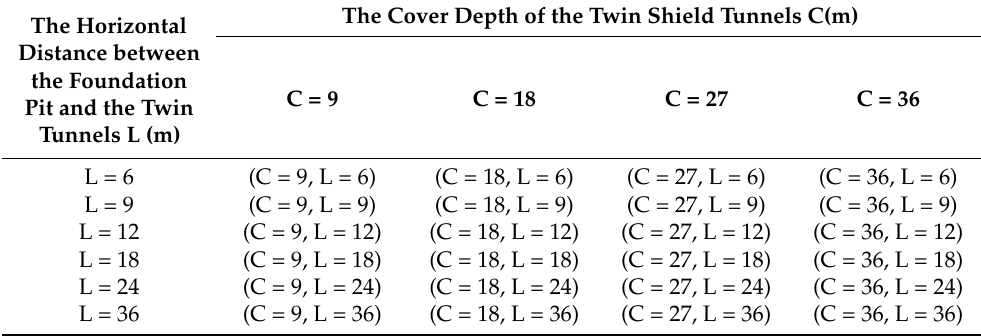
Table 4. The relative positions between the foundation pit and the twin shield